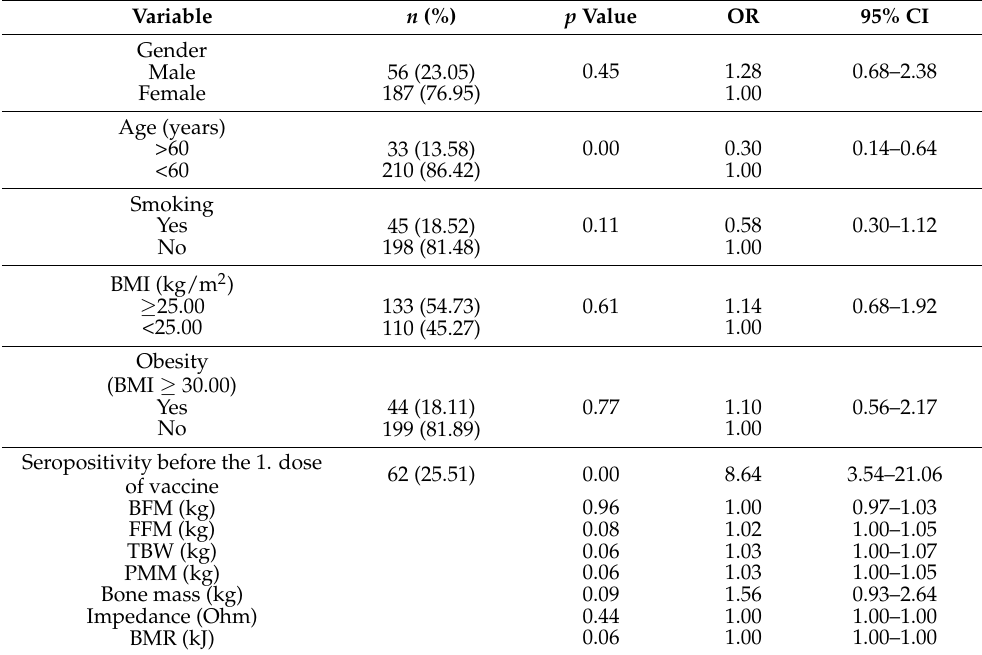
Table 3. Influence of analyzed factors on the chances of a long-term immune response. One-way logistic regression